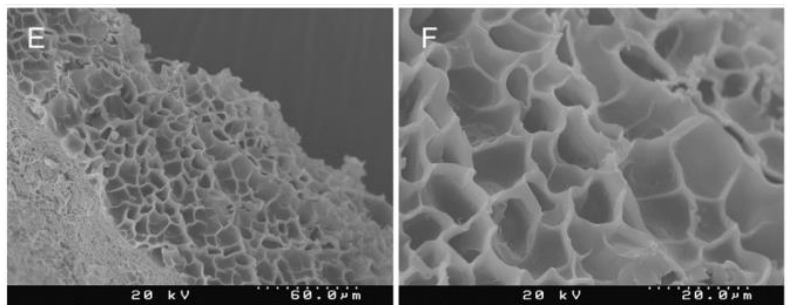
4 of 11 Figure 2. SEM images of hydrogels: ( A ) dextran at 500 × , ( B ) dextran at 1500 × , ( C ) dex-PDA with feed Figure 2. SEM images of hydrogels: ( A ) dextran at 500×, ( B ) dextran at 1500×, ( C ) dex-PDA with feed ratio of 2:1 at 500 × , ( D ) dex-PDA with feed ratio of 2:1 at 1500 × , ( E ) dex-PEI-PDA with feed ratio of 2:1:1 at 500 × , ( F ) dex-PEI-PDA with feed ratio of 2:1:1 at 1500 × . ratio of 2:1 at 500×, ( D ) dex-PDA with feed ratio of 2:1 at 1500×, ( E ) dex-PEI-PDA with feed ratio of 2:1:1 at 500×, ( F ) dex-PEI-PDA with feed ratio of 2:1:1 at 1500×. Fourier-transform infrared (FTIR) spectroscopy confirmed the incorporation of both dextran and dopamine within the dex-PDA gels (Figure 3A). The characteristic polysaccharide OH and CH stretches − 1 were observed at 3300 and 2912 cm [19]. Another peak associated with dextran is the intense peak at − 1 1002 cm , which is likely due to chain flexibility of the α (1 → 6) glycosidic bond. As the proportion of − 1 dopamine increases in dex-PDA gels, notable increases are noticed at 1590 and 1506 cm , which were ascribed to aromatic C = C and C = N stretching modes [20]. Increases in the regions attributed to C = C and C = N stretching were also observed in spectra of dex-PEI-PDA gels, confirming the PDA within the gels. It was di ffi cult to attribute peaks to PEI due to overlap with other absorptions (Figure 3B).